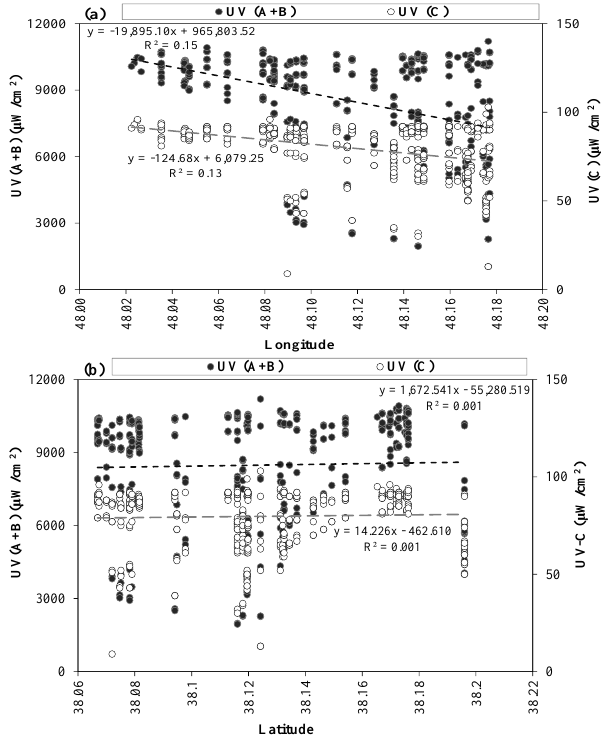
Figure 3. Scatter plot of UV (A+B) and UV (C) solar irradiances vs. local longitude (a) and local latitude (b).